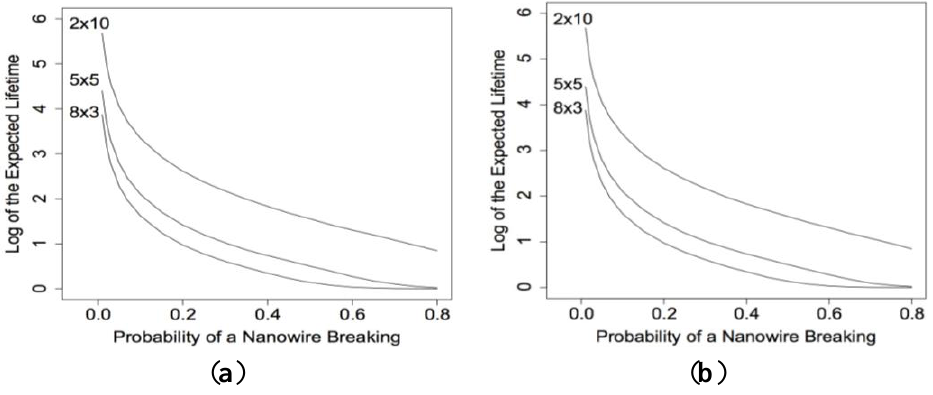
Figure 3. log E ( X ) calculated using our algorithm for various values of n and m when n × m ( a ) the electrical current can move in all directions and when ( b ) movement is restricted.